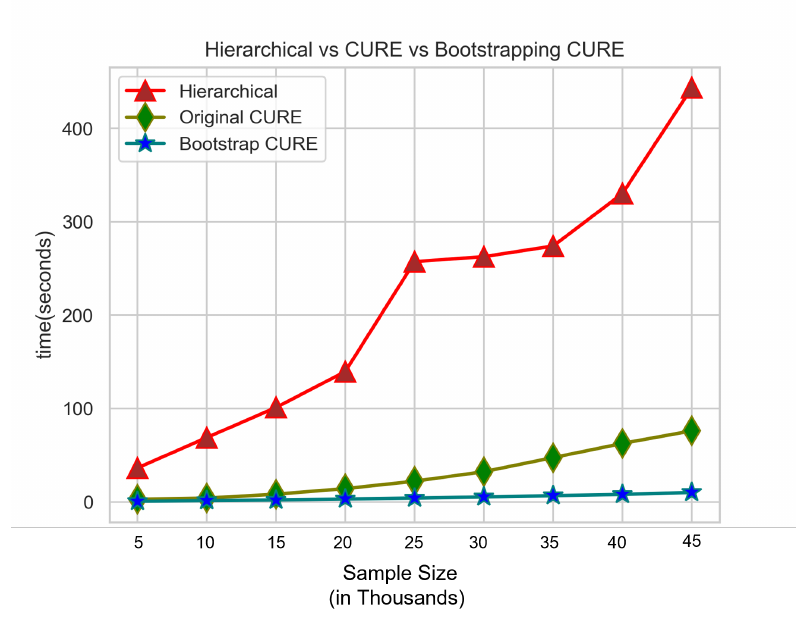
Figure 8. CPU time comparison.